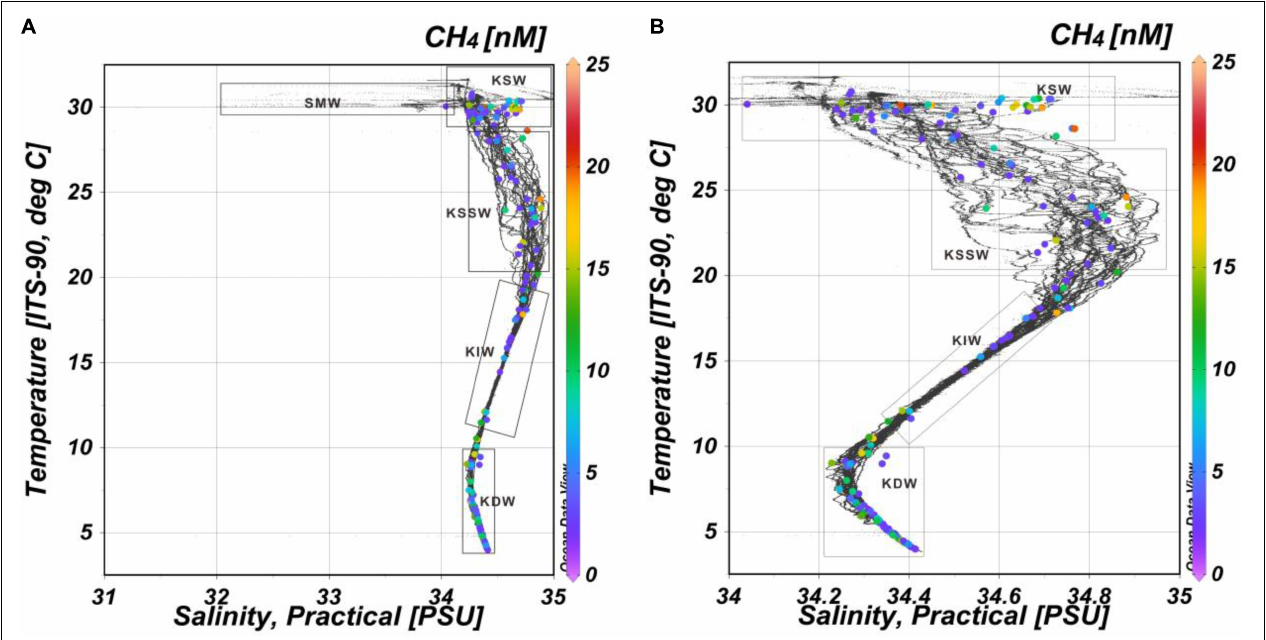
FIGURE 4 | (A) Temperature-salinity diagrams and CH 4 concentrations in the OT. (B) A larger version of the Kuroshio Water masses. The dominant water masses are classified according to a previous study (Tang et al., 1997; Li et al., 2012; Qi et al., 2014) and indicated by rectangular outlines. SMW, Shelf Mixed Water; KSW, Kuroshio Surface Water; KSSW, Kuroshio Subsurface Water; KIW, Kuroshio Intermediate Water; KDW, Kuroshio Deep Water. Black dots: non-CH 4 sampling point; Colored dots: CH 4 sampling points, with concentrations indicated by color scale. The plots were generated using ODV Version 5.1.0 (Schlitzer, 2018).